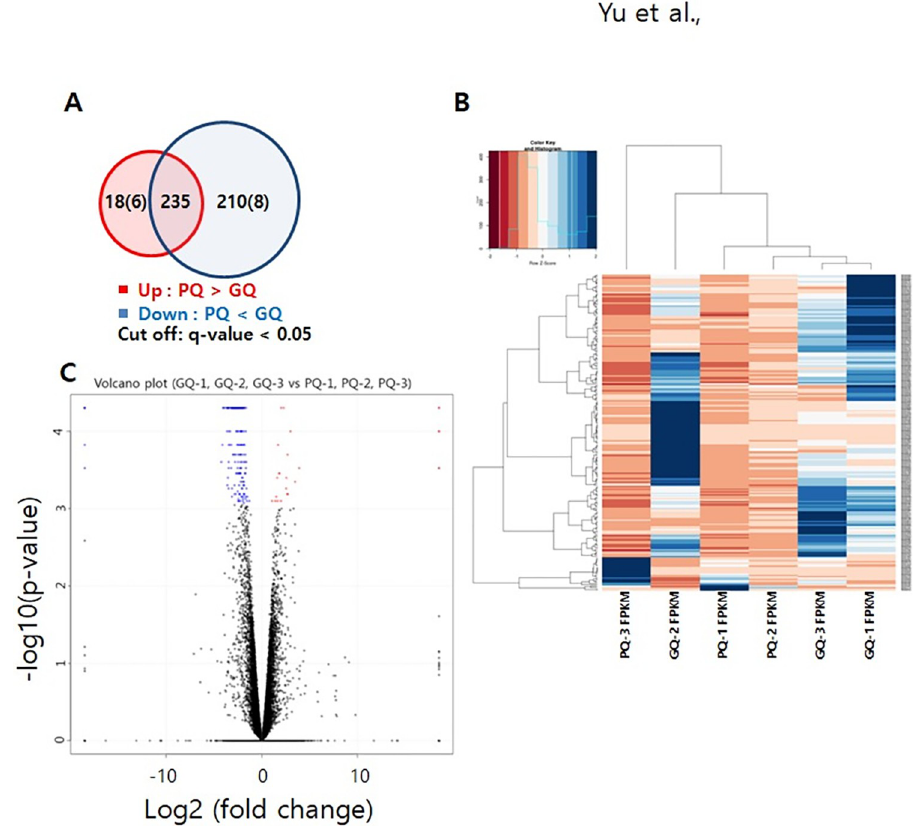
Fig 2. Hierarchical clustering and Differential Expression (DE) analysis of granulosa cells from good-quality (GQ) embryo transfer group compared with granulosa cells from poor-quality (PQ) embryo transfer group. (A) A Venn diagram depicting the distribution of significant differentially expressed genes (DEGs) (fold change > 2.5, q < 0.05) in our study. Numbers represent the number of different genes showing upregulated or downregulated expression in PQ embryo samples compared with GQ embryo samples with red representing upregulated expression and blue indicating downregulated expression. Numbers in parenthesis represent the number of DEGs in only PQ or GQ group. (B) Heatmap of the DEGs between the GQ and PQ embryo groups. The color key from blue to red represents the relative gene expression level from low to high, respectively. (C) Volcano plot showing DEG analysis between GQ embryo and PQ embryo groups using DESeq2; 640 genes were differentially expressed (210 downregulated (FC < -2 and FDR < 0.05) and 25 upregulated (FC > 2 and FDR < 0.05). The upregulated genes are represented using red dots; downregulated genes are denoted using blue dots; and the black dots indicate genes with no significant changes.